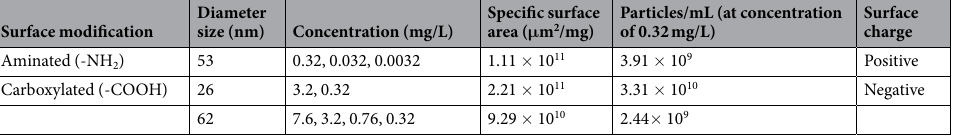
Table 1. Characteristics for particles